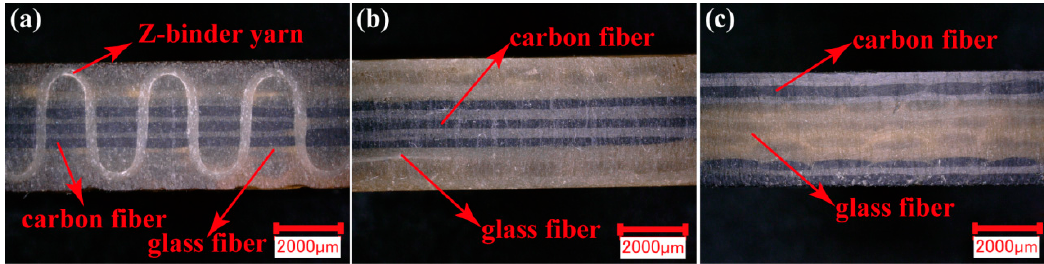
Figure 2. The cross-section microscope pictures of composites: ( a ) The 3D orthogonal woven hybrid composite (Com 1#), ( b ) the laminated orthogonal hybrid composite (Com 2#), and ( c ) the laminated orthogonal hybrid composite (Com 3#).